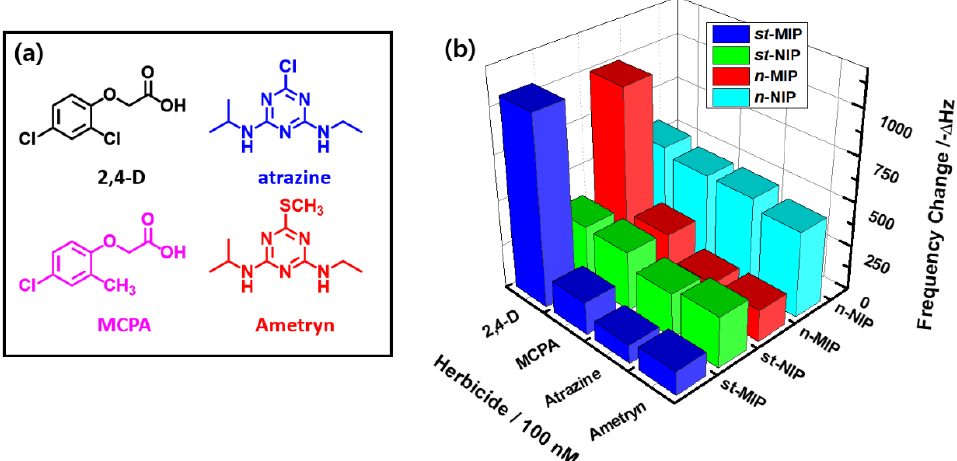
Figure 6. ( a ) Chemical structures of the three herbicide molecules and 2,4-D, and ( b ) the ∆ f values of the n - and st -MIP/NIP films in each of the analogous herbicide solution (2,4-D, atrazine, (4-chloro-2-methylphenoxy) acetic acid (MCPA), or ametryn) with a fixed concentration (100 nM) for a 2-h rebinding process.